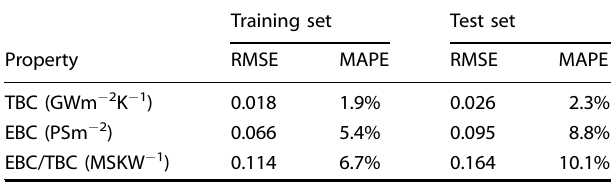
Table 3. Summary of prediction results for thermal and electrical boundary conductance (TBC and EBC) of 75 electronically realistic crystalline – crystalline grain boundaries.